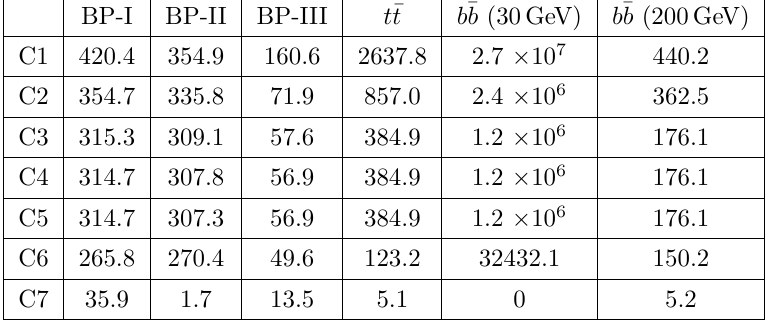
Table 3 . Cutflow table ( Signal (S)